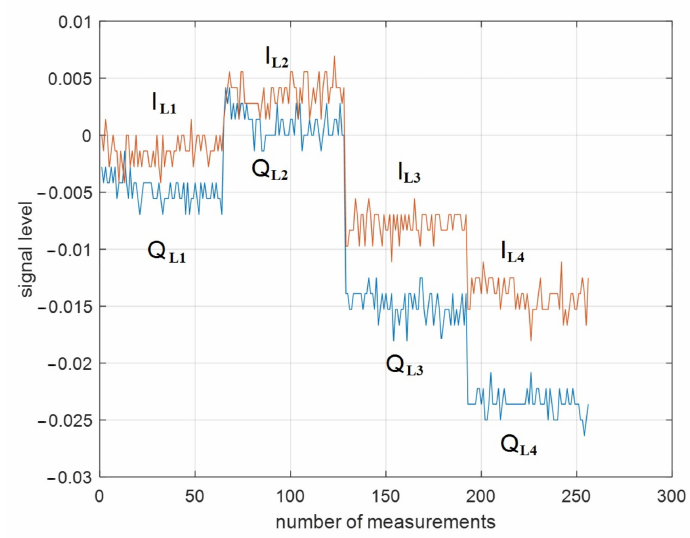
Figure 5. Unprocessed linear polarization target signature (truck, profile angle 45 ◦ ): I L1 , Q L1 —horizontal transmission and vertical reception, respectively; I L2 , Q L2 —vertical transmission and vertical reception, respectively; I L3 , Q L3 —vertical transmission and horizontal reception, respectively; I L4 , Q L4 —horizontal transmission and horizontal reception, respectively.